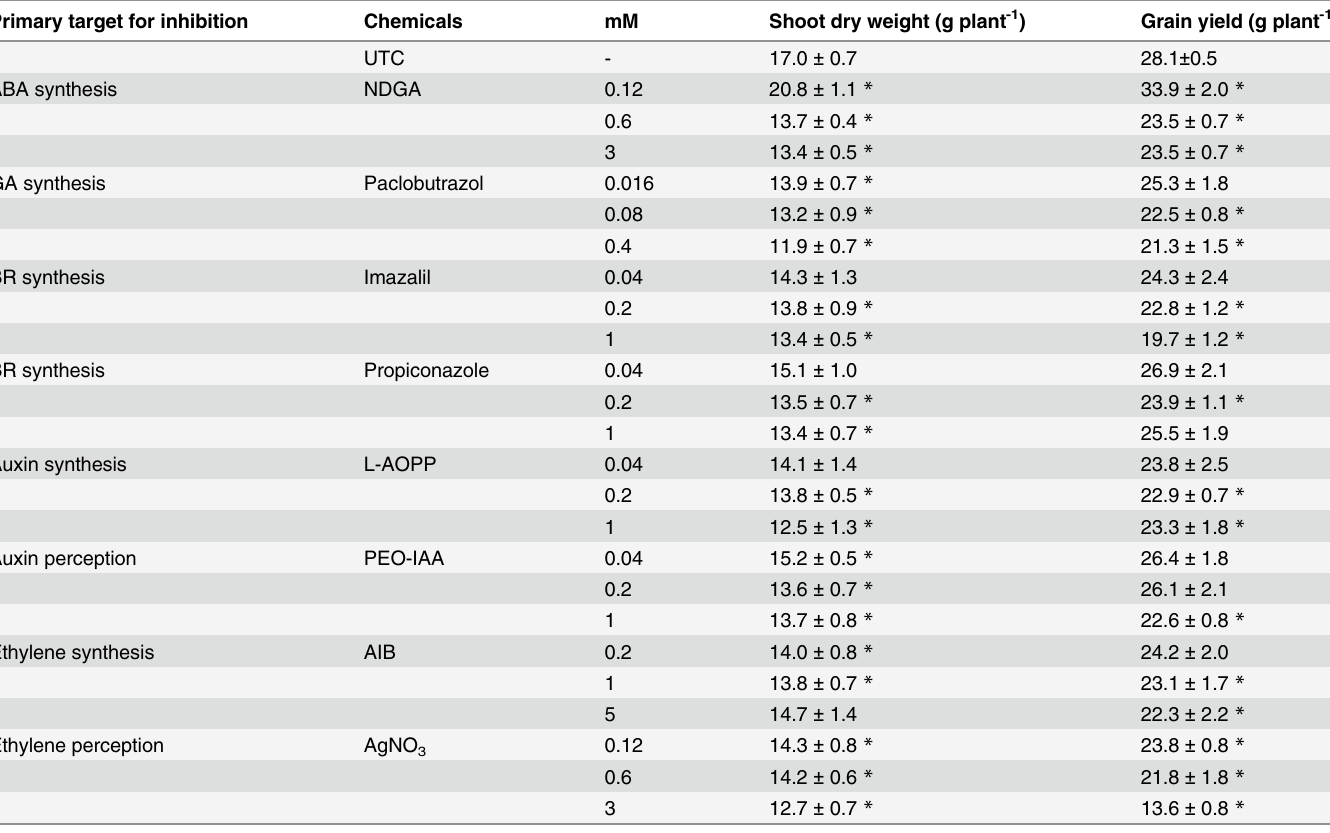
Table 1. Effects of plant hormone inhibitors applied at pre-anthesis on the shoot dry weight and grain